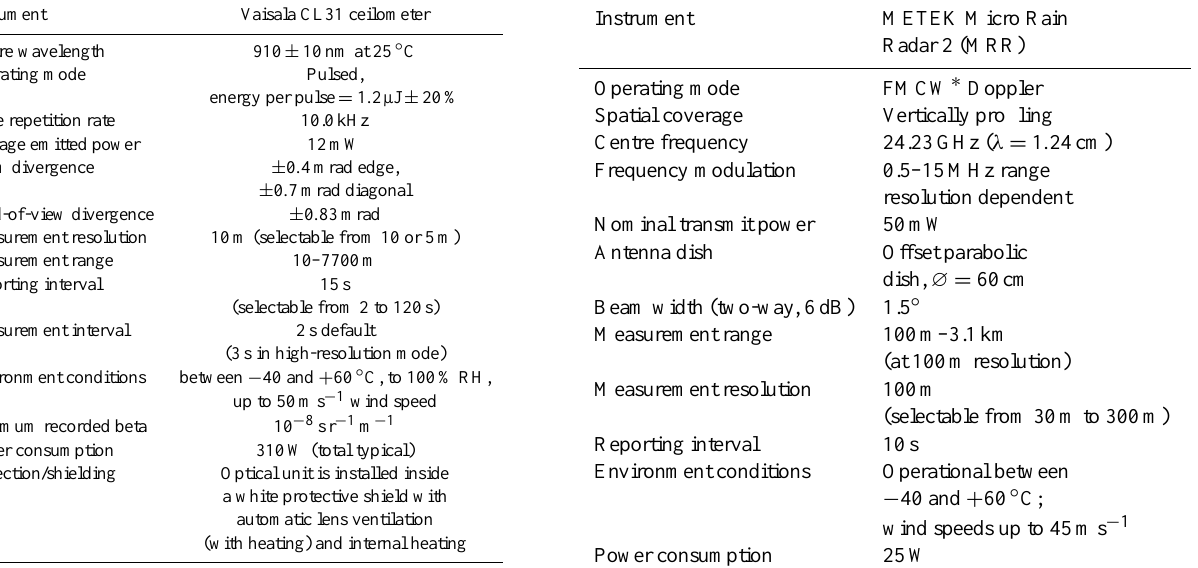
Table 2. Specifications of the HYDRANT ceilometer.